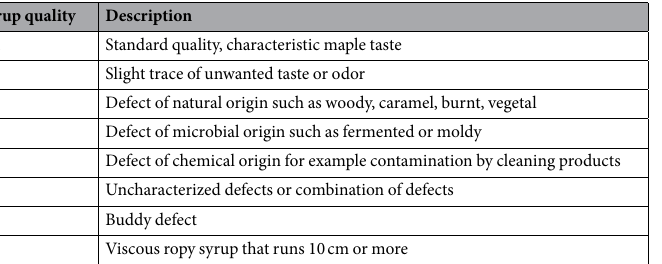
Table 1. The official maple syrup classification system in Quebec. a Syrups in these classes can also present the buddy